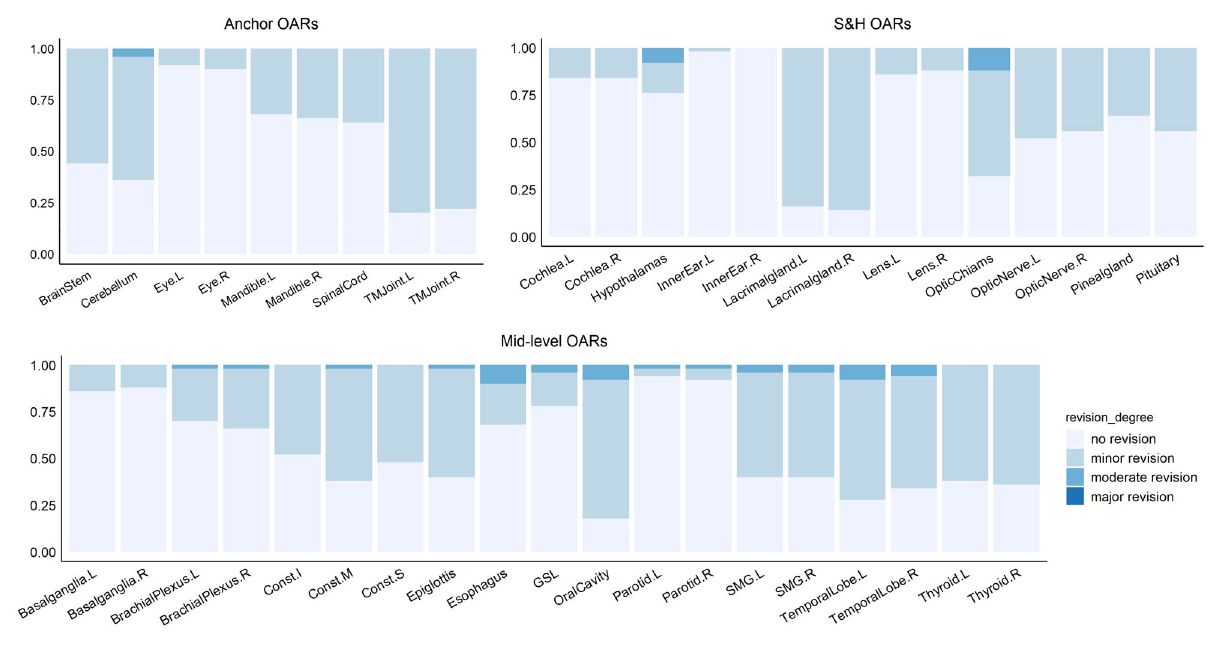
Fig. 3 | Summary of human experts ’ assessment of revision effort on SOARS predicted 42 OARs using 50 multi-user testing patients. Anchor, mid-level and S&HOARcategoriesareshownseparately.VastmajorityofSOARSpredictedOARs only required minor revision or no revision from expert ’ s editing before they can